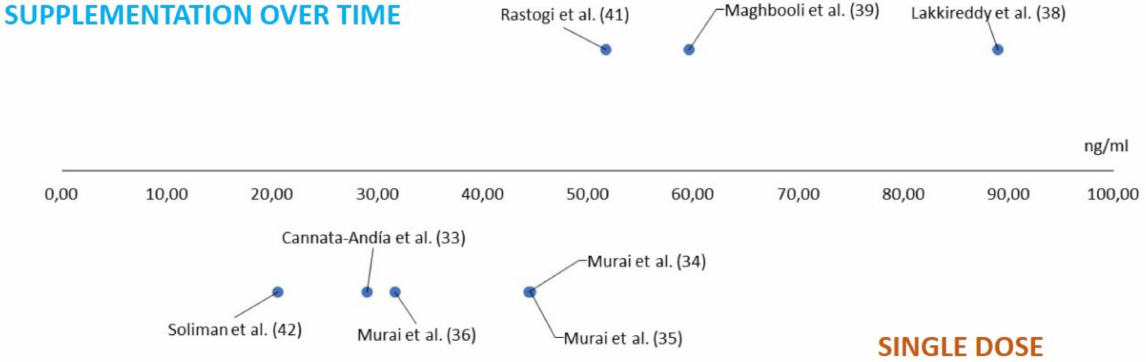
Figure 3. Mean plasma vitamin D levels after supplementation. Cannata-And í a et al. [33]; Murai et al. [34]; Fernandes et al. [35]; Murai et al. [36]; Lakkireddy et al. [38]; Maghbooli et al. [39]; Rastogi et al. [41]; Soliman et al.